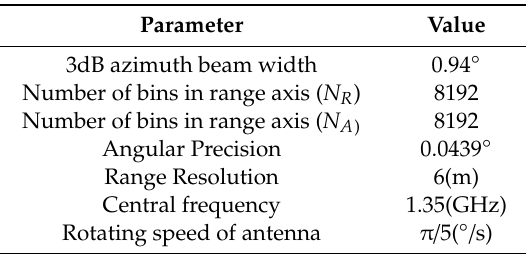
Table 1. Parameters of the radar.